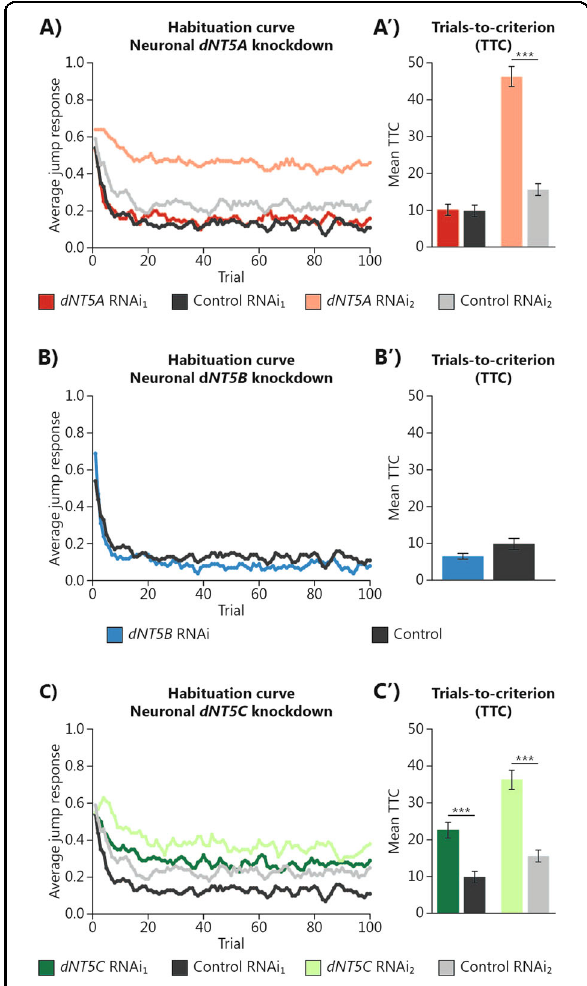
Fig. 2 Neuronal manipulation of dNT5A and dNT5C expression causes habituation de fi cits. A – C Average jumping response of A dNT5A , B dNT5B , and C dNT5C pan-neuronal RNAi induction upon 100 consecutive light-off stimuli. A ′ , B ′ , C ′ Quanti fi cation of trials-to-criterion (TTC). A Pan-neuronally induced dNT5A RNAi 2 ( w ; 2xGMR - wIR / UAS - dNT5A RNAi 2 ; nSyb - Gal4 , UAS - Dcr2 , n = 176) habituated slower than the RNAi 2 control ( w ; 2xGMR - wIR / + ; nSyb - Gal4 , UAS - Dcr2 , n = 123), while RNAi 1 ( w ; 2xGMR - wIR; nSyb - Gal4 , UAS - Dcr2 / UAS - dNT5A RNAi 1 , n = 122) habituated similarly to its control ( w ; 2xGMR - wIR; nSyb - Gal4 , UAS - Dcr2 / + , n = 112). B Pan-neuronally induced dNT5B RNAi ( w ; 2xGMR - wIR; nSyb - Gal4 , UAS - Dcr2 / UAS - dNT5B RNAi , n = 97) habituated similarly to control ( w ; 2xGMR - wIR; nSyb - Gal4 , UAS - Dcr2 / + , n = 112). C Pan-neuronally induced dNT5C RNAi 1 ( w ; 2xGMR - wIR; nSyb - Gal4 , UAS - Dcr2 / UAS - dNT5C RNAi 1 , n = 161) and RNAi